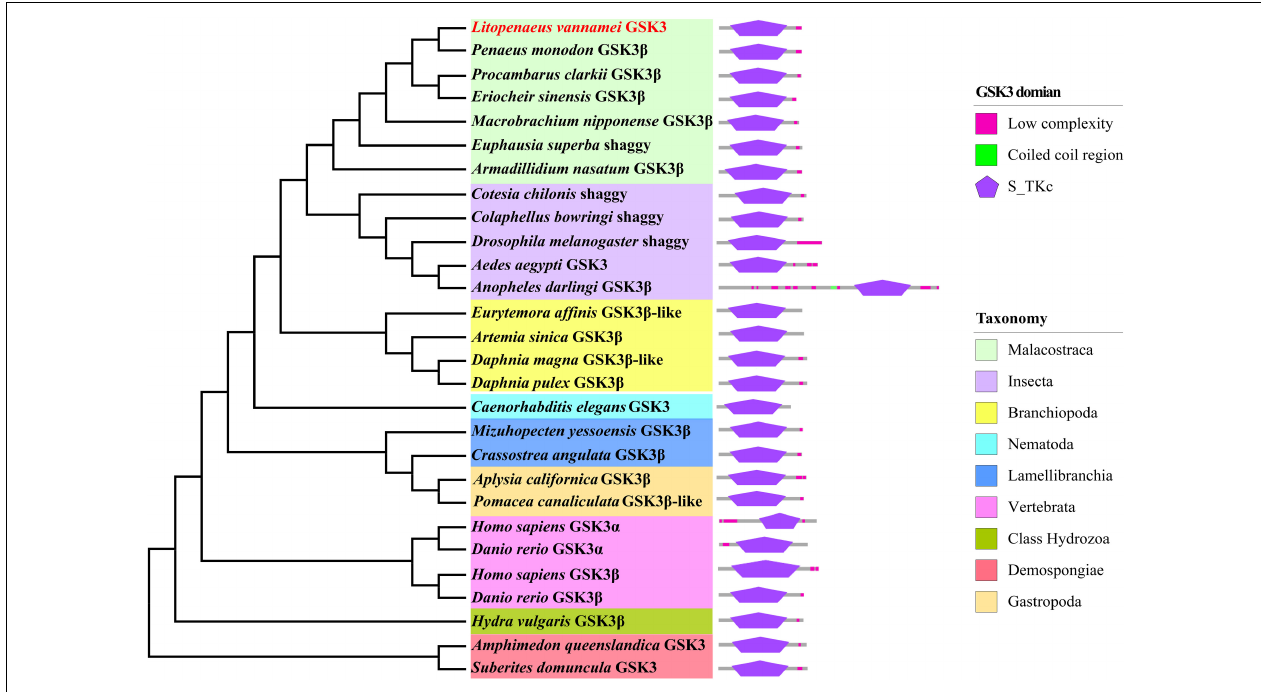
FIGURE 1 | GSK3s’ phylogenetic tree and their